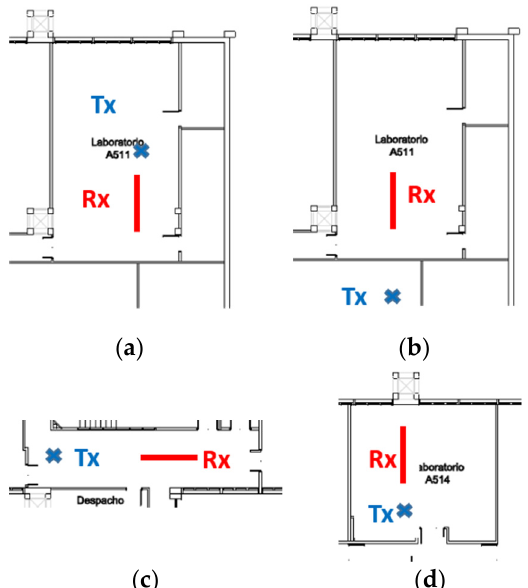
Figure 3. Environment schemes for measurements in the 5 GHz band ( a ) large lab LoS; ( b ) large lab NLoS; ( c ) office #2; and ( d ) small lab #3. NLoS; ( c ) office #2; and ( d ) small lab